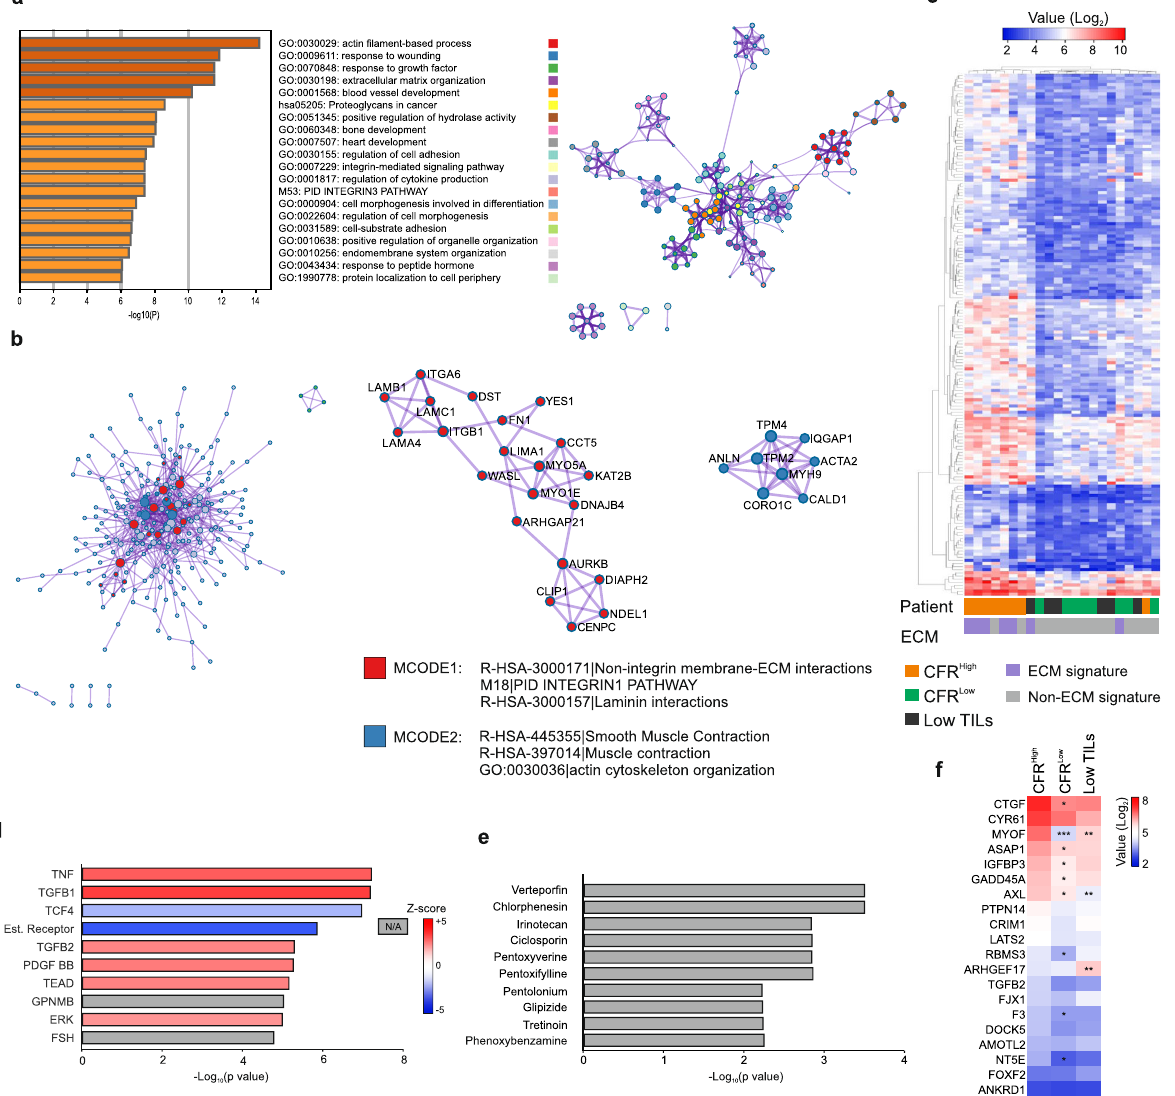
interactions. b MCODE-identi fi ed neighborhoods of densely connected proteins based on upregulated genes in the high CFR group showing their corresponding enriched Gene Ontologies. c Heat map of gene expression of signi fi cantly altered genes in the CFR-de fi ned groups with patient clustering indicating their corresponding ECM signature as de fi ned by Binzer-Panchal et al. d Ingenuity pathway analysis (IPA) indicates the potential upstream regulators of the differential gene expression between CFR high and low tumors. e Connectivity Map analysis shows potential gene expression-altering drugs for the upregulated genes in the CFR High compared to CFR Low groups. f Expression of 22 YAP- TEAD target genes in CFR groups and Low TILs. Signi fi cance is indicated as *( P < 0.05), **( P < 0.01), ***( P <